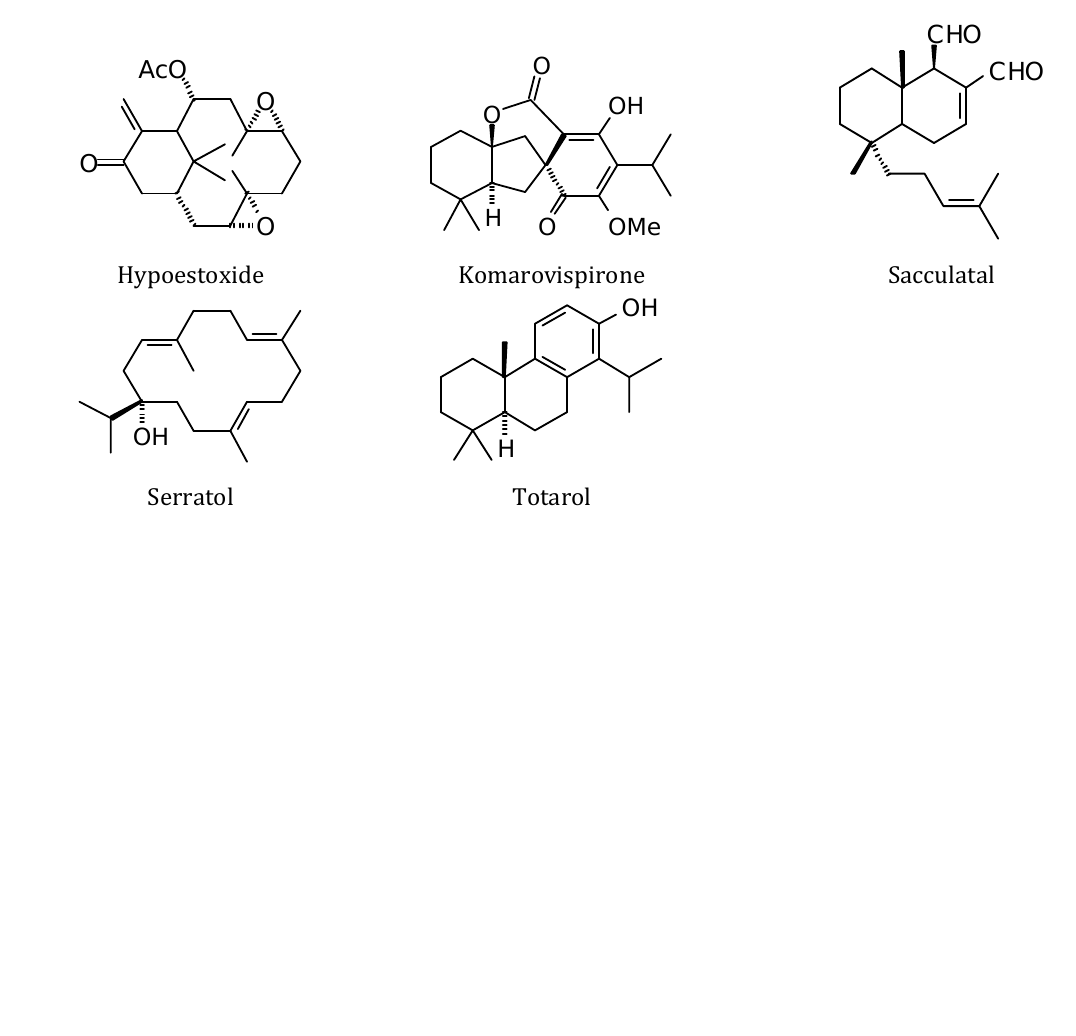
Figure 18. Miscellaneoous diterpenoids examined in this